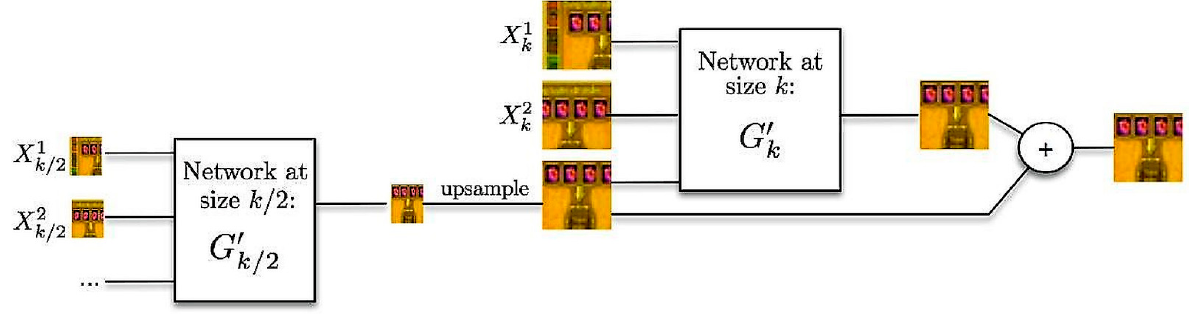
Figure 4. Multi-scale architecture [59].